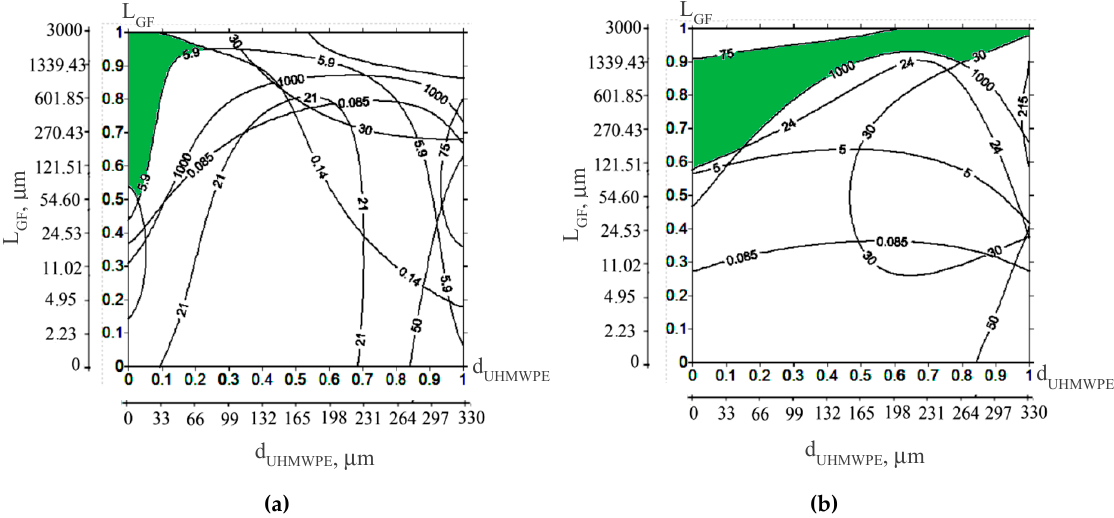
Figure 14. Areas that determine the rational diameter of the UHMWPE powder and the length of the glass fibers required to obtain compositions with the specified properties: without treatment ( a ), after the treatment with “KH-550” ( b ).